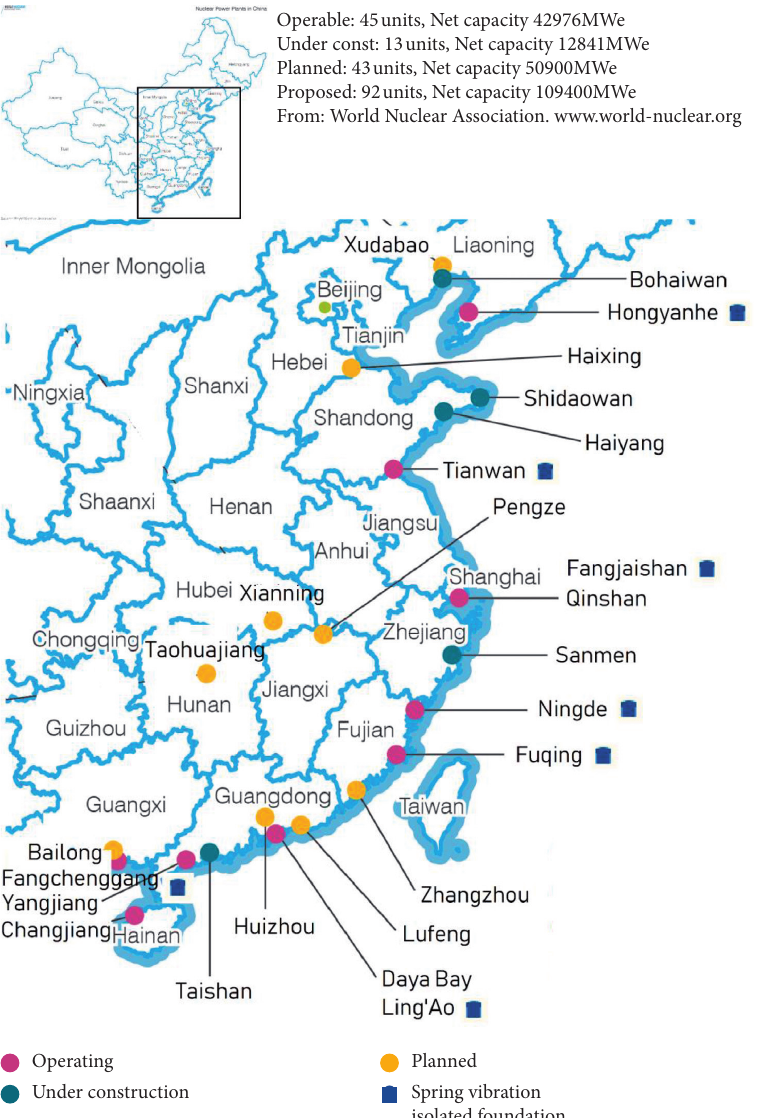
Figure 1: Nuclear power plants in